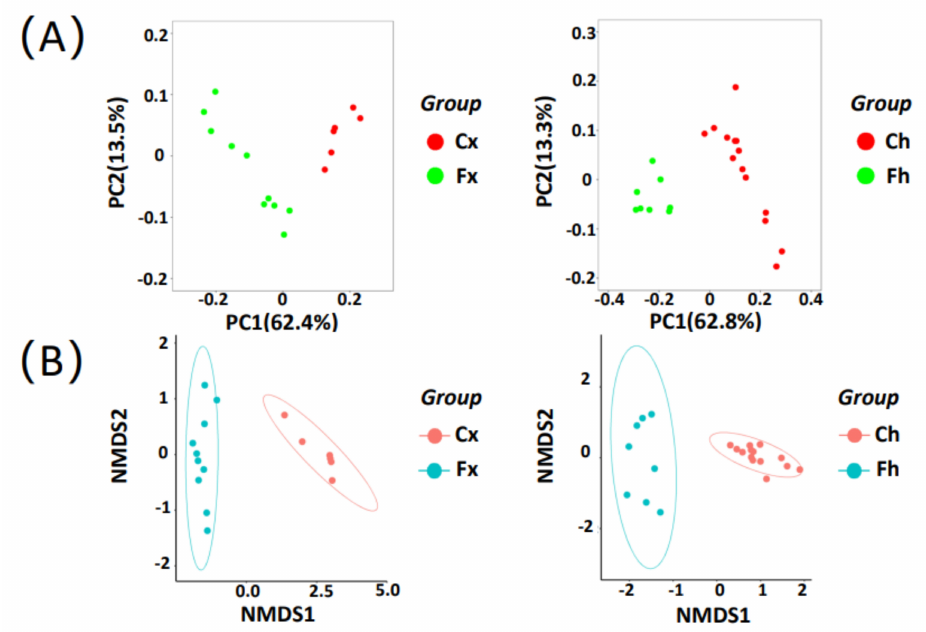
Figure 3. Analysis of the intestinal flora composition of free-range yaks and captive yaks: ( A ) principal component analysis (PCoA) based on unweighted UniFrac distance shows the distribution between samples of different groups; ( B ) nonmetric multidimensional scaling (NMDS) based on Bray-Curtis distance analyzed the microbiome similarity of samples. PC1, PC2, NMDS1, and NMDS2 are the first two principal components in dimension reduction of the sample data,